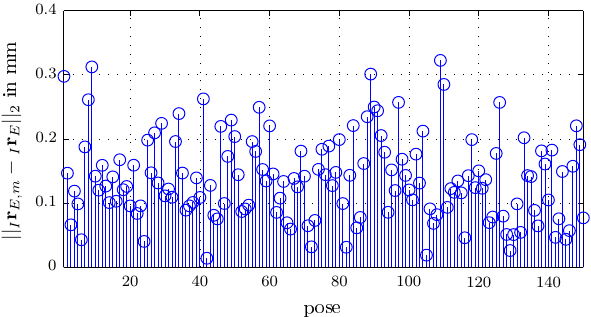
Figure 13. Absolute error of the end-effector for the 150 verifica- tion